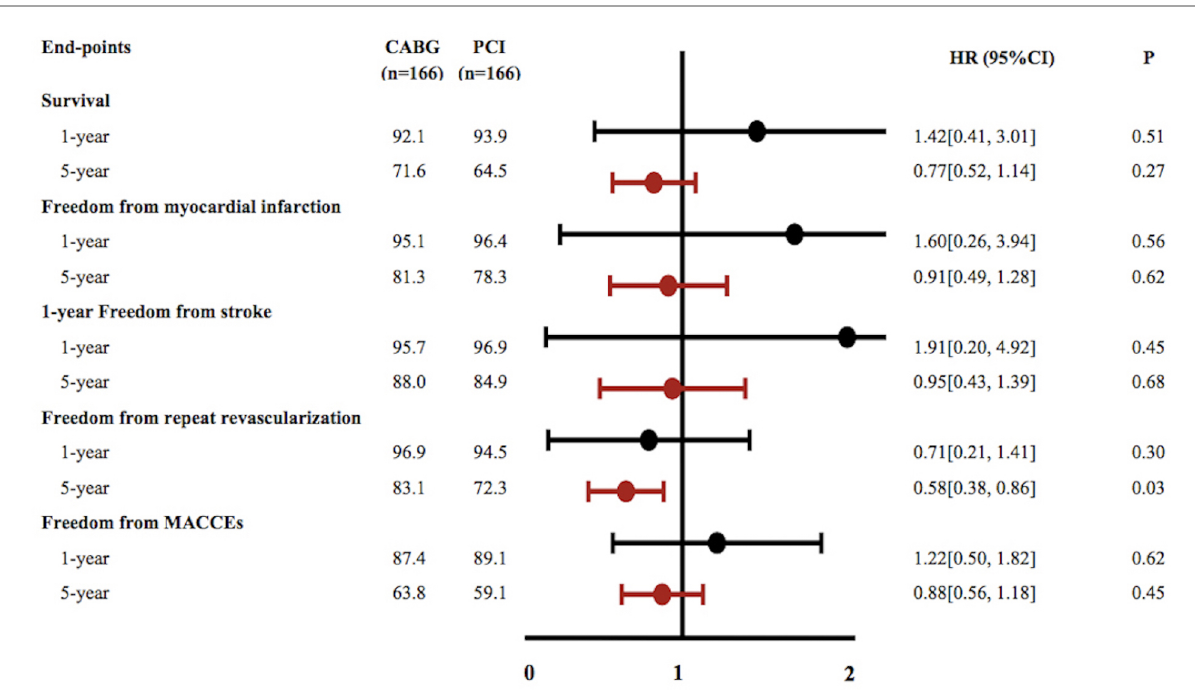
FIGURE 2 Cumulative event curves for outcomes of survival, freedom from myocardial infarction, freedom from stroke, freedom from repeat revascularization and freedom from major adverse cardiovascular and cerebrovascular events ( A – E ). Curves generated using the Kaplan – Meier approach Forest plot showing associations for different endpoints. Hazard ratios and 95% con fi dence intervals generated from Cox proportional hazards regression without covariate adjustment. Black squares and lines show point estimates and 95% CI for patients with PCI while Red squares and lines re fl ect associations for patients with